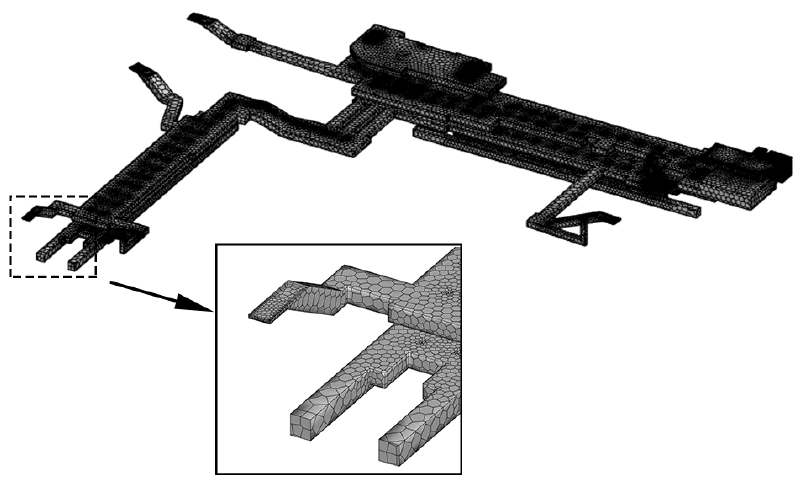
Figure 6. Meshing diagram of the target study station.